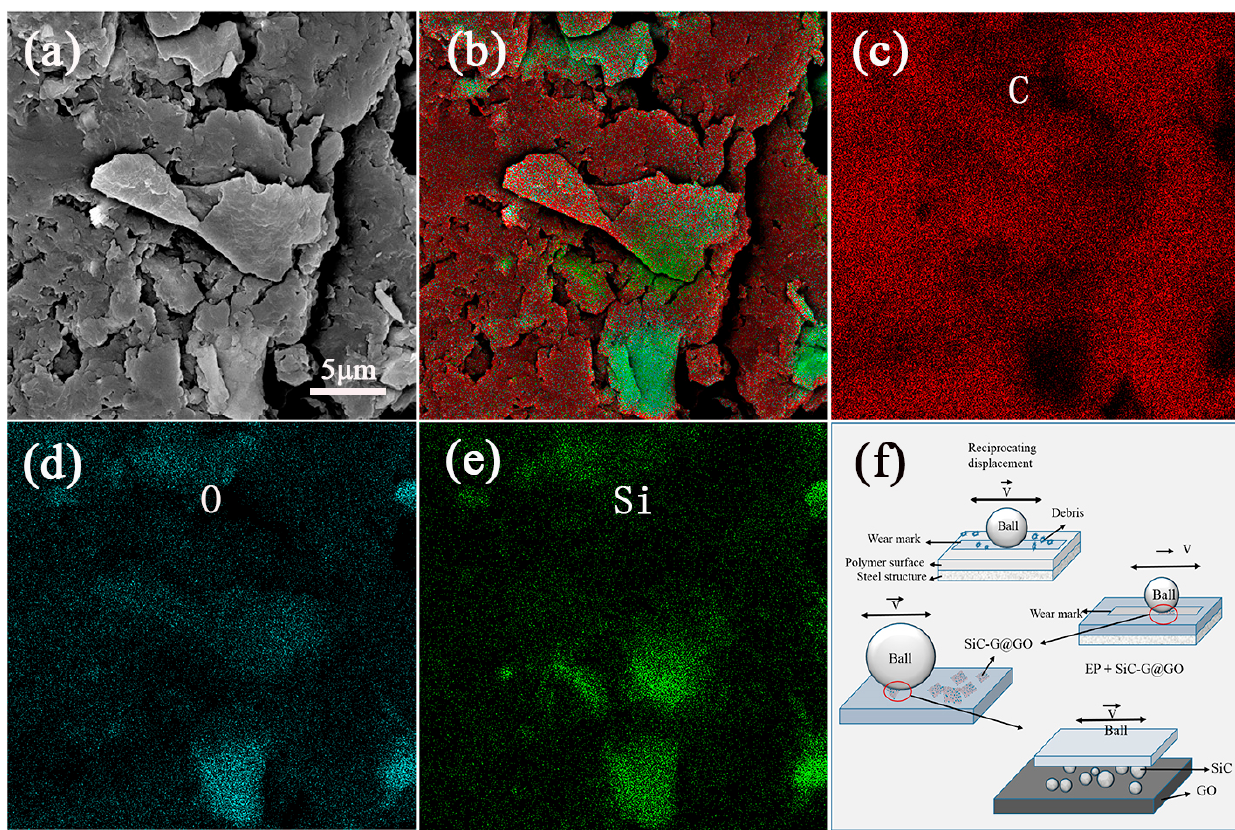
Figure 19. ( a ) FE-SEM image of SiC-G@GO 1 wear scars; ( b – e ) EDS images of C, O, and Si elements of SiC-G@GO 1 wear scars; ( f ) schematic diagram of rolling friction.